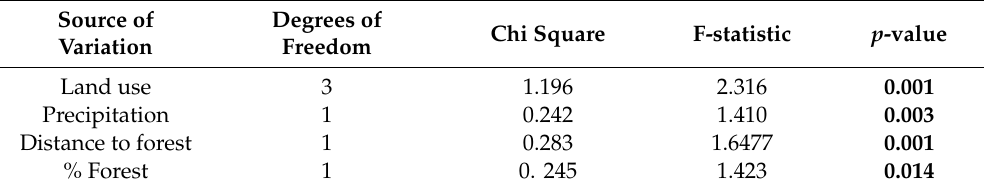
Table 3. Shift in lichen species composition in relation to predictor variables, measured with ANOVAlike permutation test in four riparian land uses of Andean streams in southern Ecuador. Significant di ff erences at p -value ( < 0.05) are shown in bold. DBH: diameter at breast